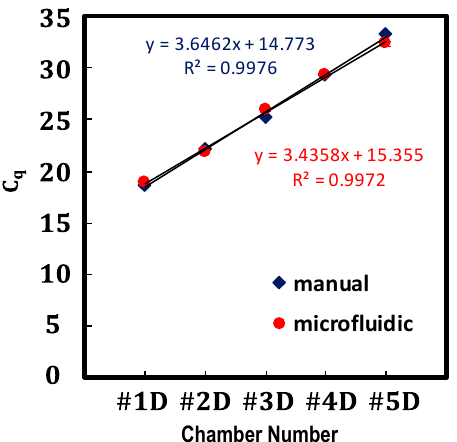
Figure 7. Plots of the measured qPCR cycle quantification values, C q , against the concentrations of serially diluted cDNA samples ranging from 10 0 to 10 − 4 , obtained by using the proposed microfluidic device and manual pipetting.